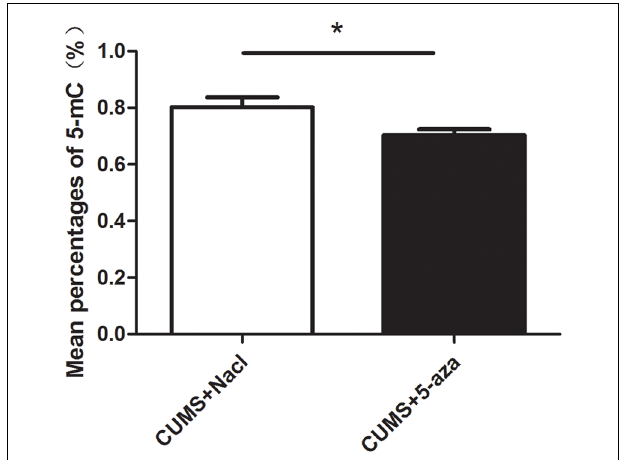
FIGURE 7 | Effect of 5-aza administration on global DNA methylation in the CA1 region of the hippocampus. * P < 0.05.